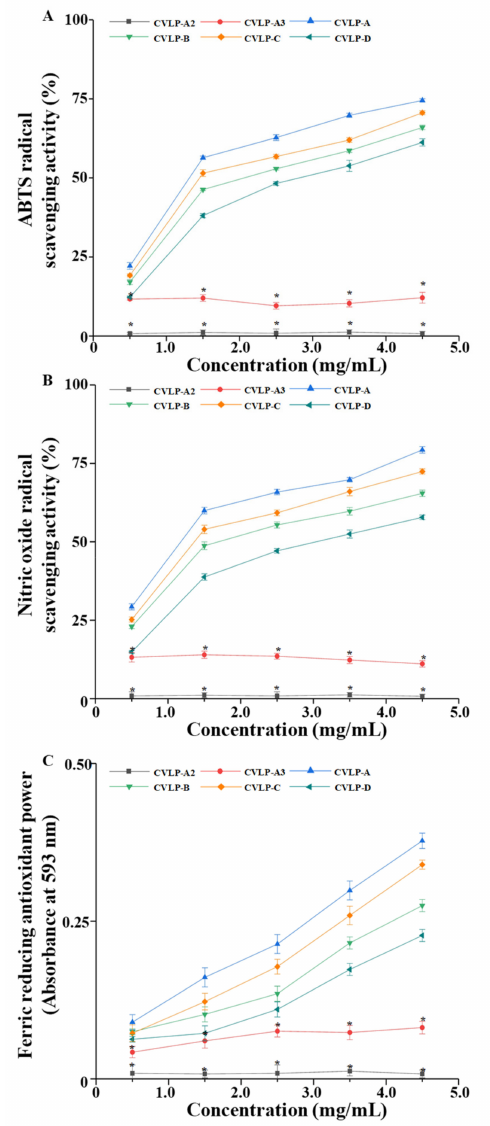
Figure 4. ABTS radical scavenging activities ( A ), nitric oxide (NO) radical scavenging activities ( B ) and ferric reducing antioxidant powers ( C ) of CVLPs and their acidic and enzymatic hydrolysates CVLP-A , CVLP-B , CVLP-C and CVLP-D , crude polysaccharides extracted from the leaves of C. violaceum collected from Chengdu, Langzhong, Bazhong and Guangyuan, respectively. CVLP-A2 , partial acidic hydrolysates of CVLP-A; CVLP-A3 , pectinase enzymatic hydrolysates of CVLP-A. Values represent mean ± standard deviation. Significant ( p < 0.05) di ff erences of ABTS radical scavenging activities, NO radical scavenging activities and FRAP between CVLP-A, CVLP-A2 and CVLP-A3 at the same concentration are shown by *; Statistical significances were determined by A.N.O.V.A. and Duncan’s